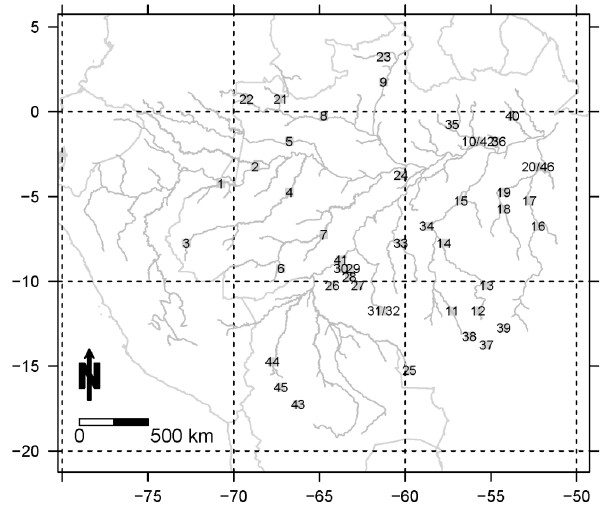
Fig. 2. The 44 sites used for comparison of observed and simulated Figure 2. The 44 sites used for comparison of observed and simulated discharge. 824